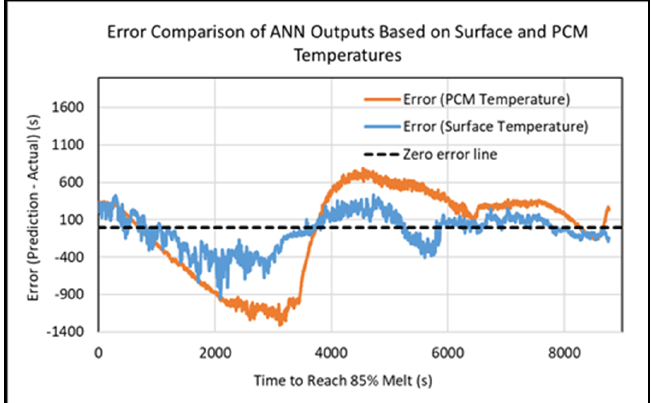
Figure 20. Comparison of error in predictions from the ANN model trained using transient surface- temperature data and transient PCM-temperature data (for test data set of 2.8 V and training data set of 2.3 V).